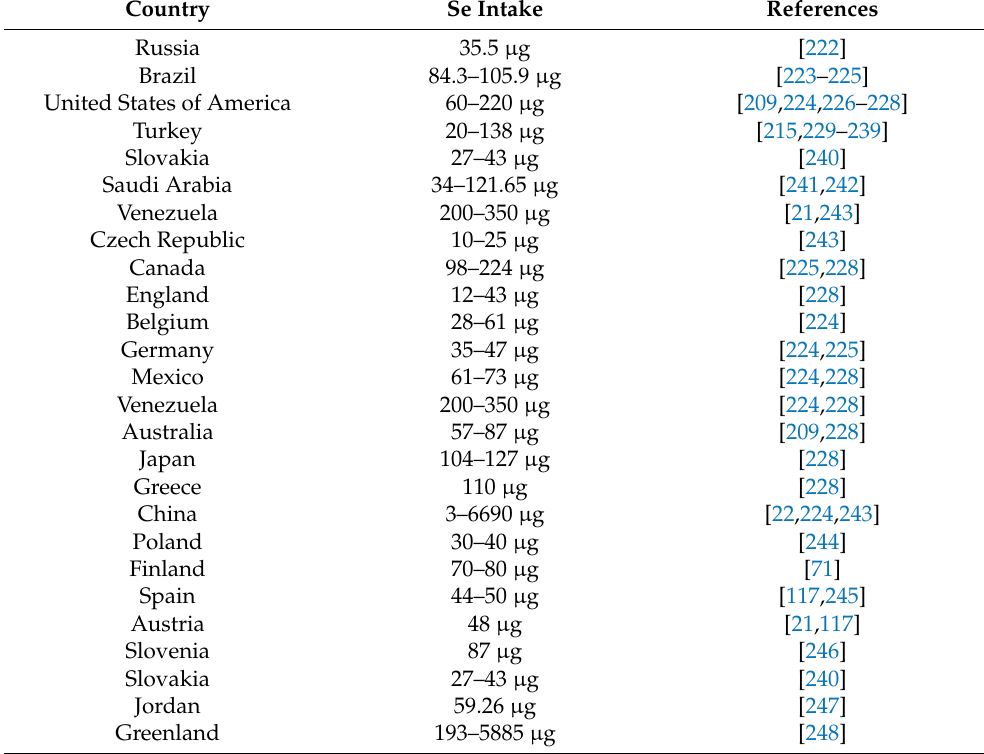
Table 3. Se intake status in different countries.